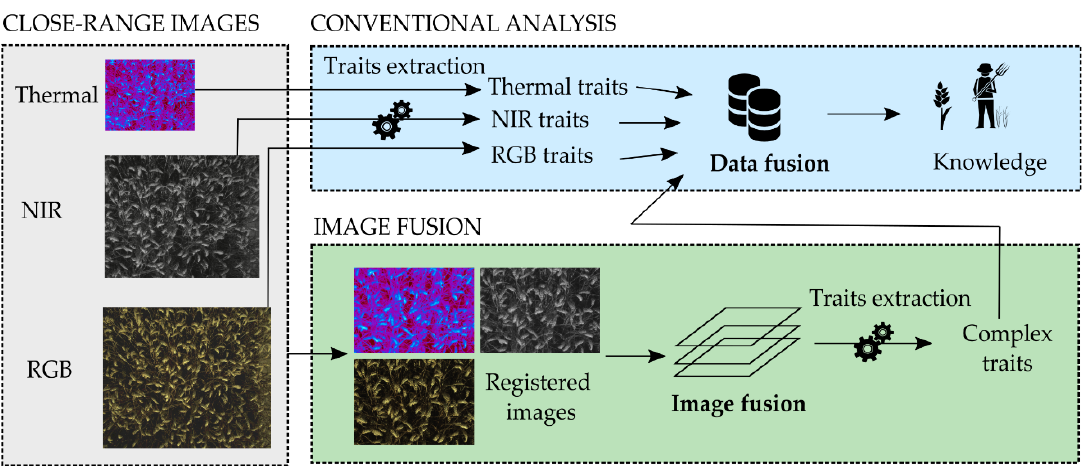
Figure 1. Difference between conventional data fusion and image fusion.